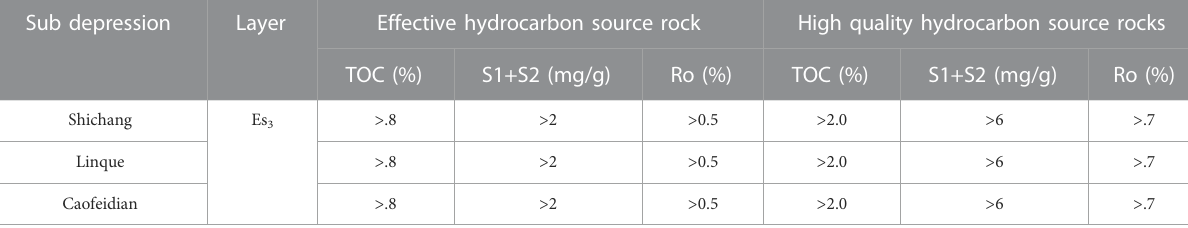
TABLE 1 Identi fi cation criteria of Es 3 source rocks in Nanpu Sag. Sub